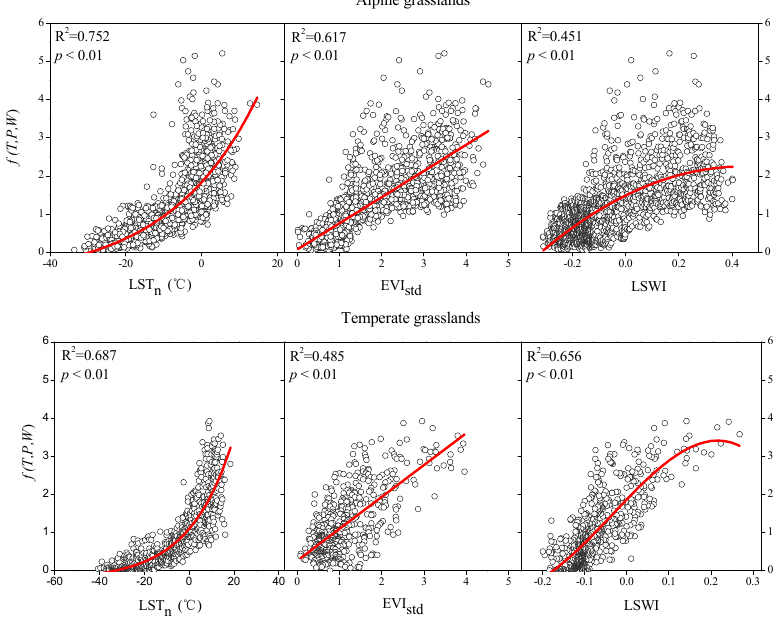
Figure 4. f ( T , P , W ) response to nighttime LST ( LST n ), standardized EVI ( EVI std ), and LSWI for the Tibetan alpine grasslands and the Inner Mongolian temperate grasslands.